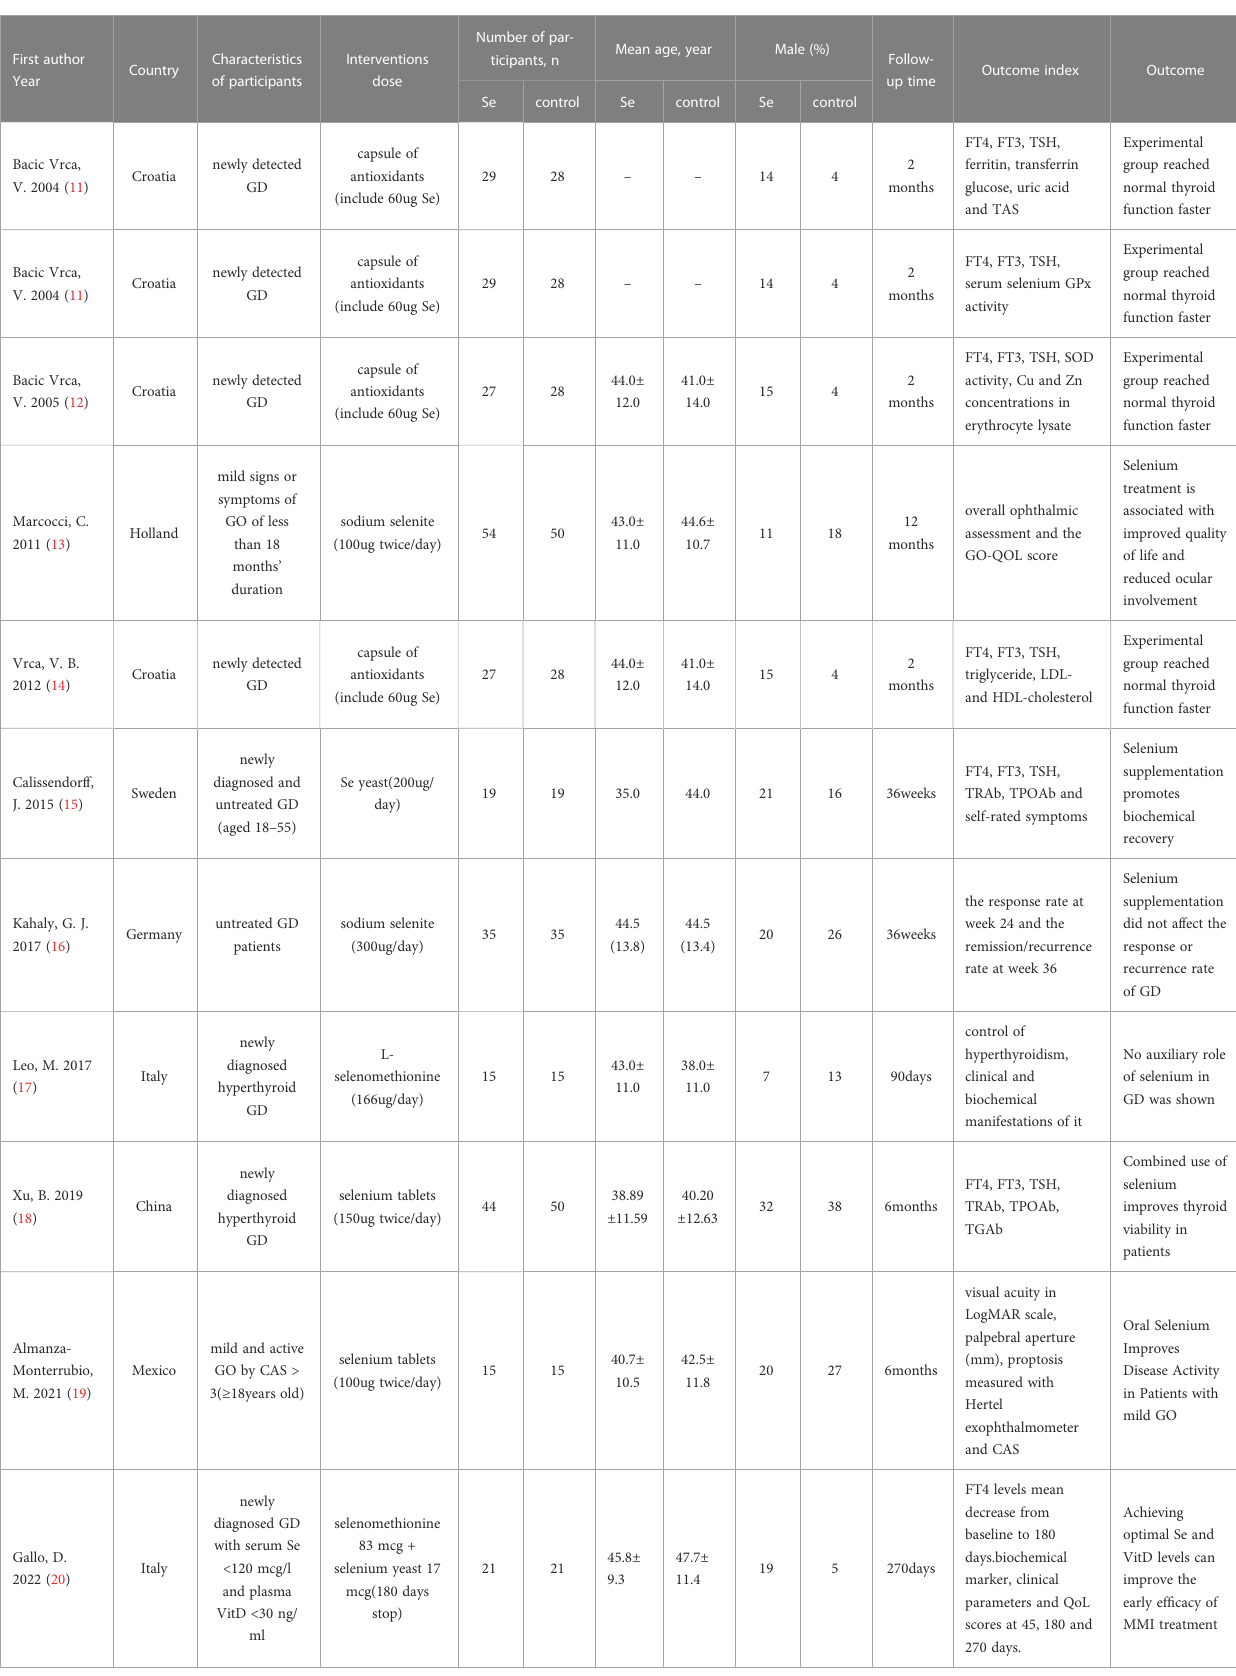
Achieving optimal Se and VitD levels can improve the early ef fi cacy of MMI